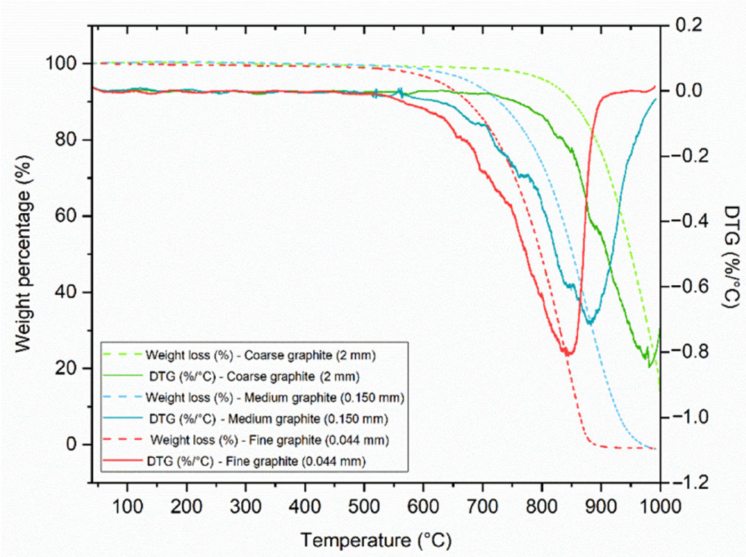
Figure 2. Characterization of the three graphite products by thermogravimetric analysis (TGA), showing the weight loss from 100 to 1000 ◦